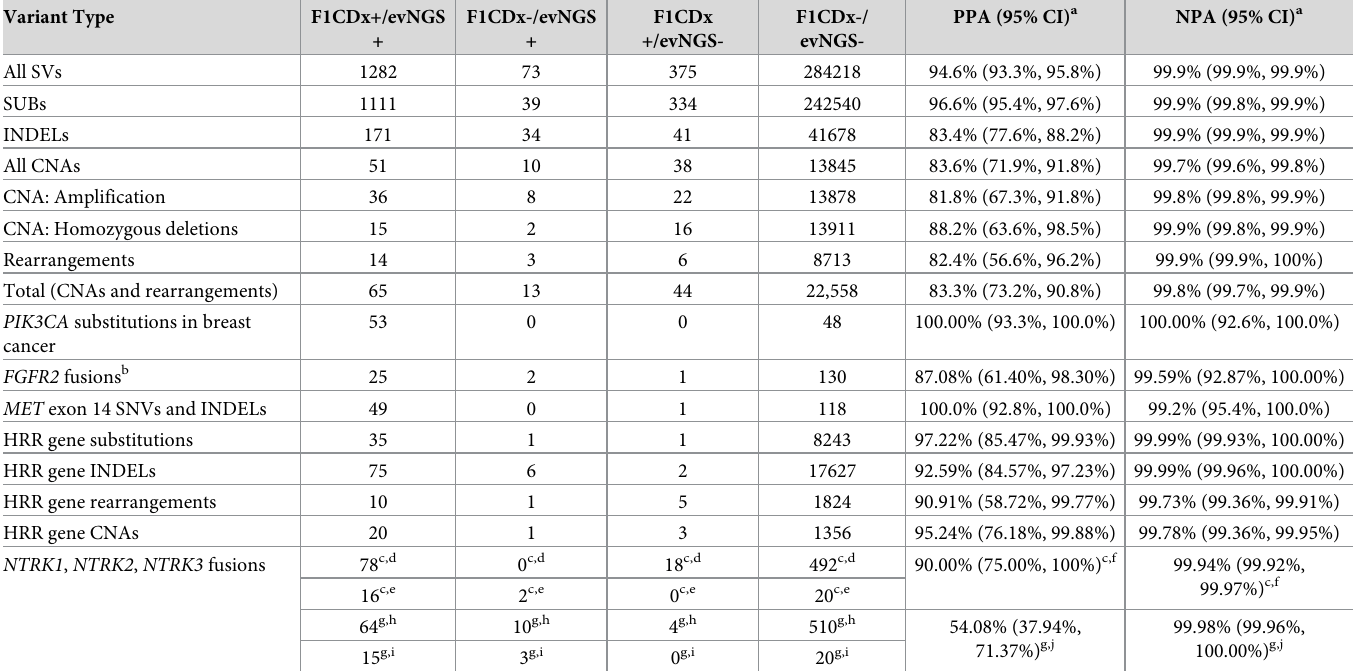
Table 11. Concordance of F1CDx and an externally validated NGS assay for platform-wide variants and CDx biomarkers. Variant